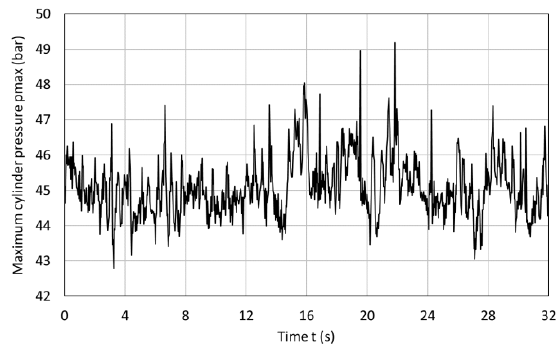
Fig. 8. Maximum cylinder pressure for operating point No.